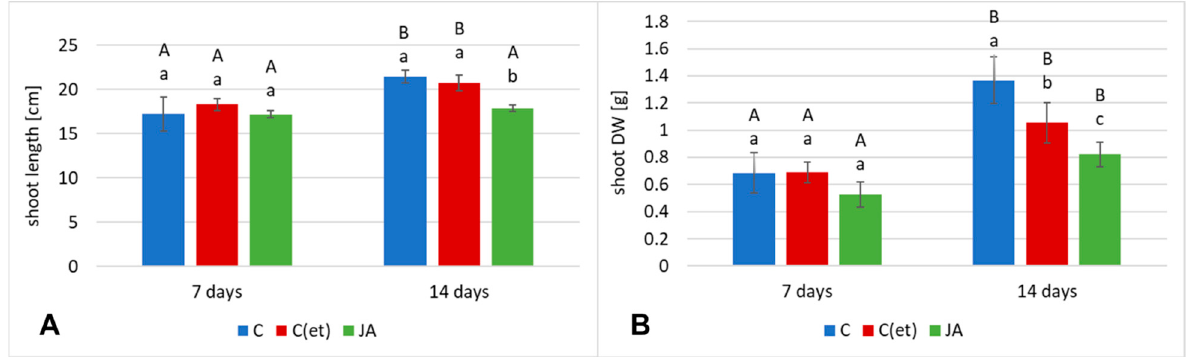
Figure 9. The length ( A ) and dry weight DW ( B ) of C. officinalis plant shoots. C—control, C(et)—control samples treated with the adequate volume of 70% ethanol, JA—jasmonic acid-elicited samples. Bars which do not share a common letter are significantly different. Capital letters indicate significant difference in time between plants from the same treatment, lowercase indicate difference between treatments within certain time point.